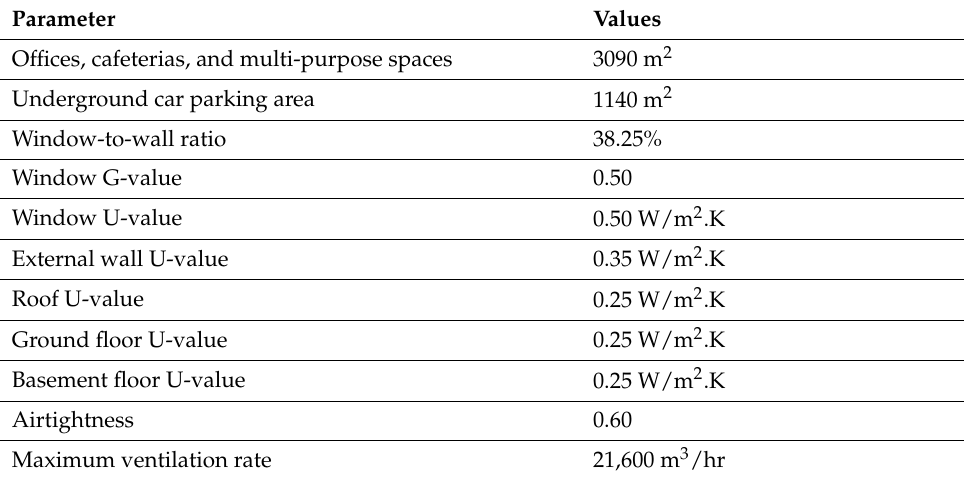
Table 2. Reference nearly zero-energy office building characteristics.